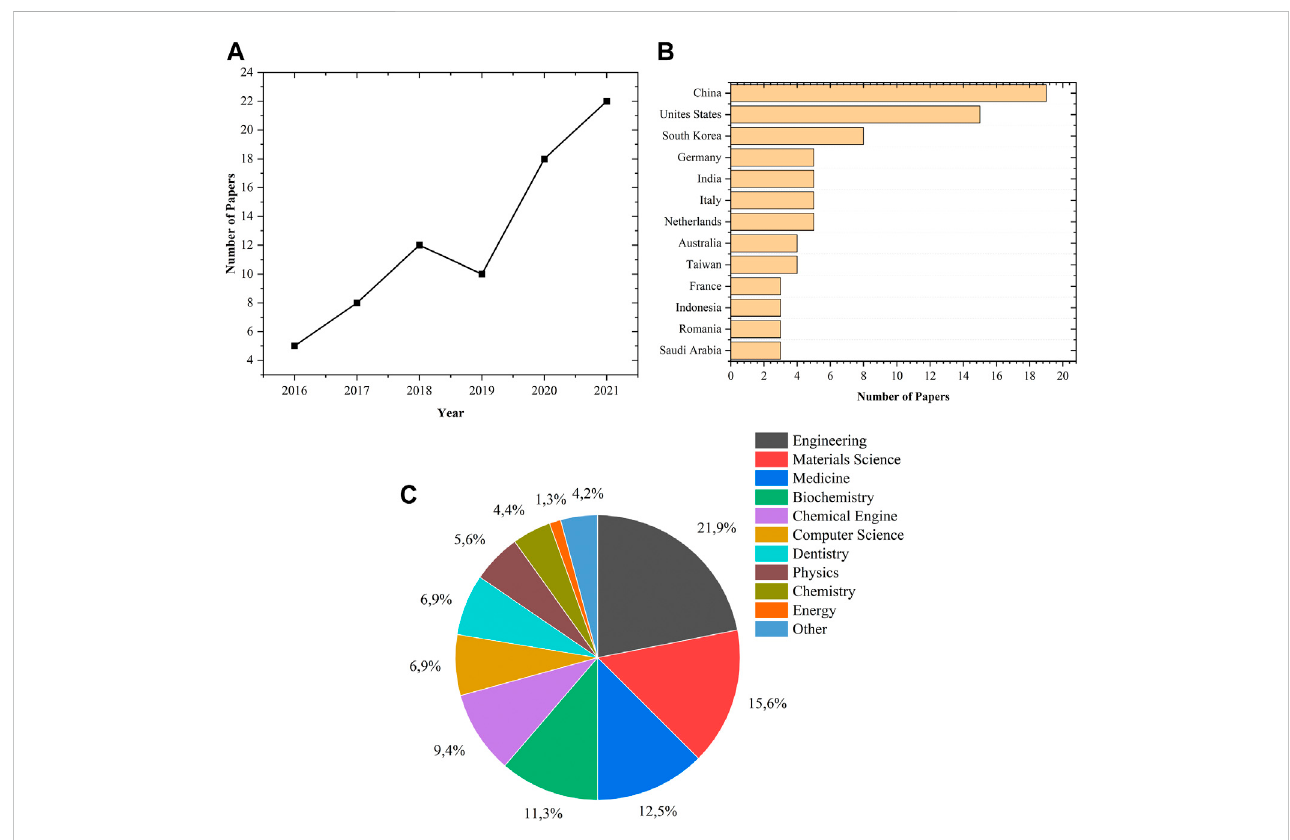
FIGURE 2 (A) Trend by year, (B) Trend by country, (C) Map by subject area.